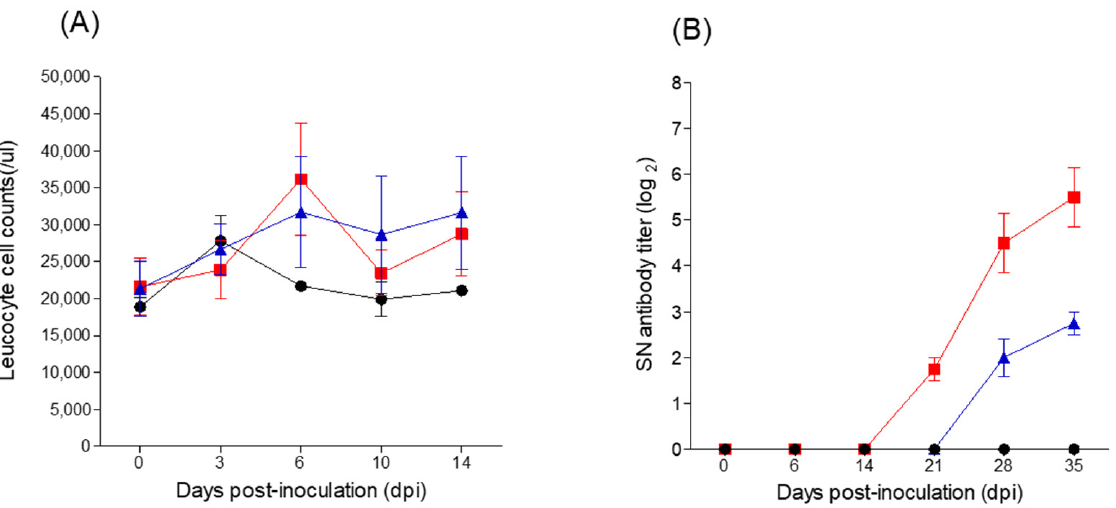
Figure 3. Changes in leukocyte cell counts and serum-neutralizing antibody titers in pigs experimentally infected with BVDV-1a and -2a. Leukocyte cell counts ( A ) and neutralizing antibody titers ( B ). Pigs inoculated with BVDV-1a, BVDV-2a, or no virus (mock infection) are shown as red squares, blue triangles, and black circles, respectively.